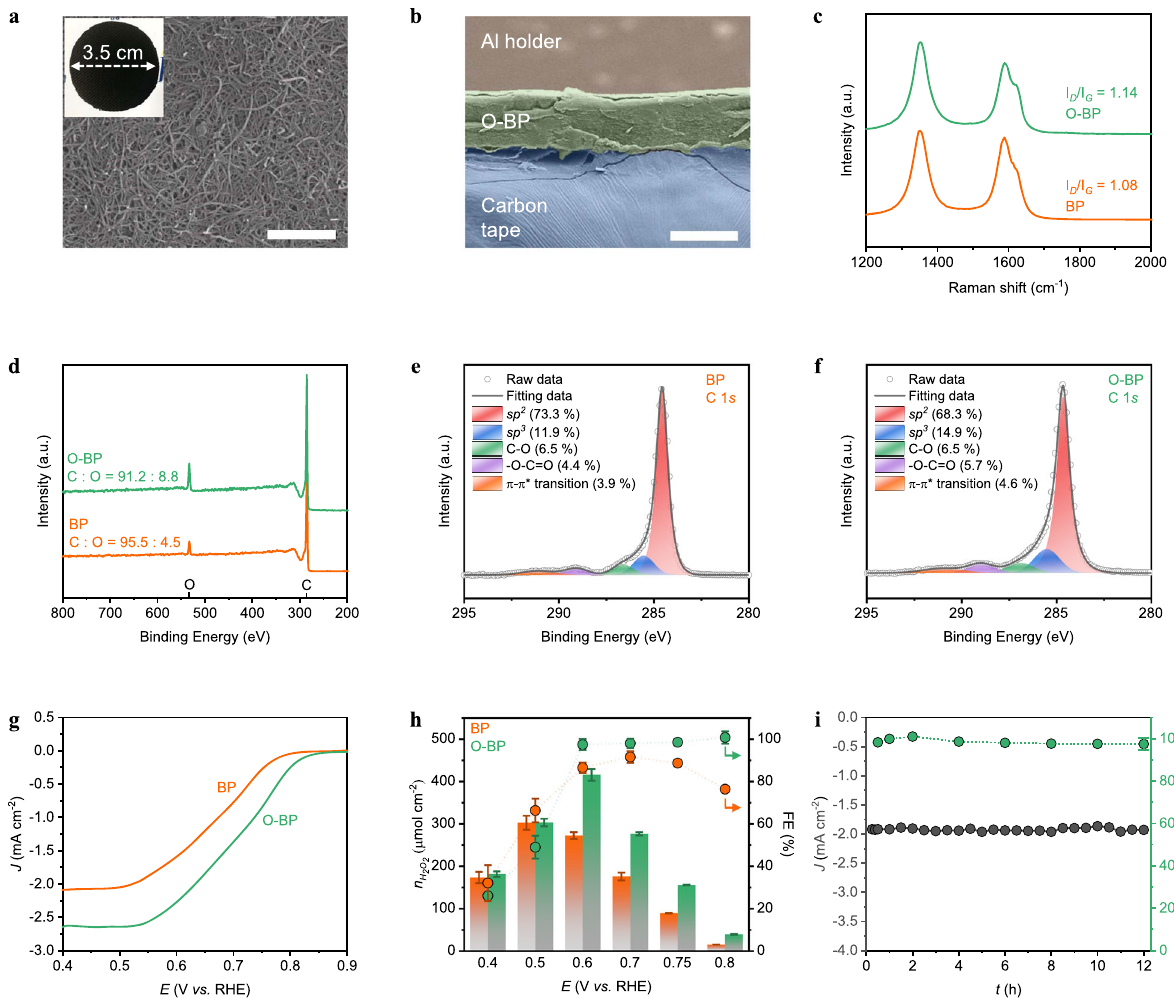
Fig. 2 Characterisation and oxygen reduction performance of carbon materials. a Top-view scanning electron micrographs of O-BP. Inset photograph, O-BP after being removed from a polytetra fl uoroethylene membrane. Scale bar, 1 μ m. b Cross-section scanning electron micrographs of O-BP. Scale bar, 100 μ m. c Raman spectra of BP and O-BP. d X-ray photoelectron spectroscopy (XPS) surveys of BP and O-BP. Deconvoluted carbon 1 s spectra of BP ( e ) and O-BP ( f ). g Capacitive current compensated linear sweep voltammetry (LSV) of BP and O-BP evaluated at a 10 mV s − 1 scan rate. h Amount of H 2 O 2 produced ( n ) and the faradaic ef fi ciency (FE) of BP and O-BP during 12 h of controlled potential electrolysis (CPE). Here, the error bars indicate the standard deviation. i Long-term CPE test of O-BP at − 0.6 V vs. RHE. g – i All experiments were conducted in 0.1 M KOH solution (pH ~13.17) under O 2 and ambient conditions with